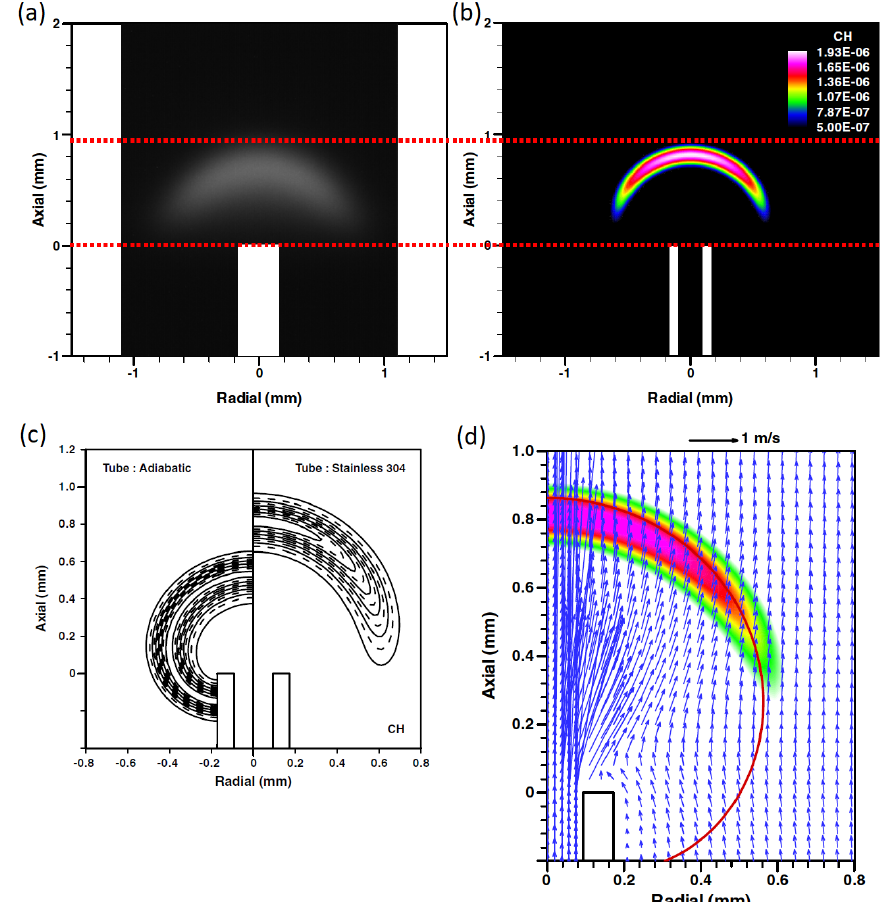
Figure 5. Numerical study of a microjet methane diffusion flame near extinction by Chen et al. [13]. Top : Comparison of the measured CH* image ( a ) with computed CH mass fraction isopleths ( b ); Bottom : Comparison of CH contours calculated with adiabatic and variable wall temperature conditions ( c ), and Computed 2-D velocity vector coupled with CH isopleths in the standoff region ( d